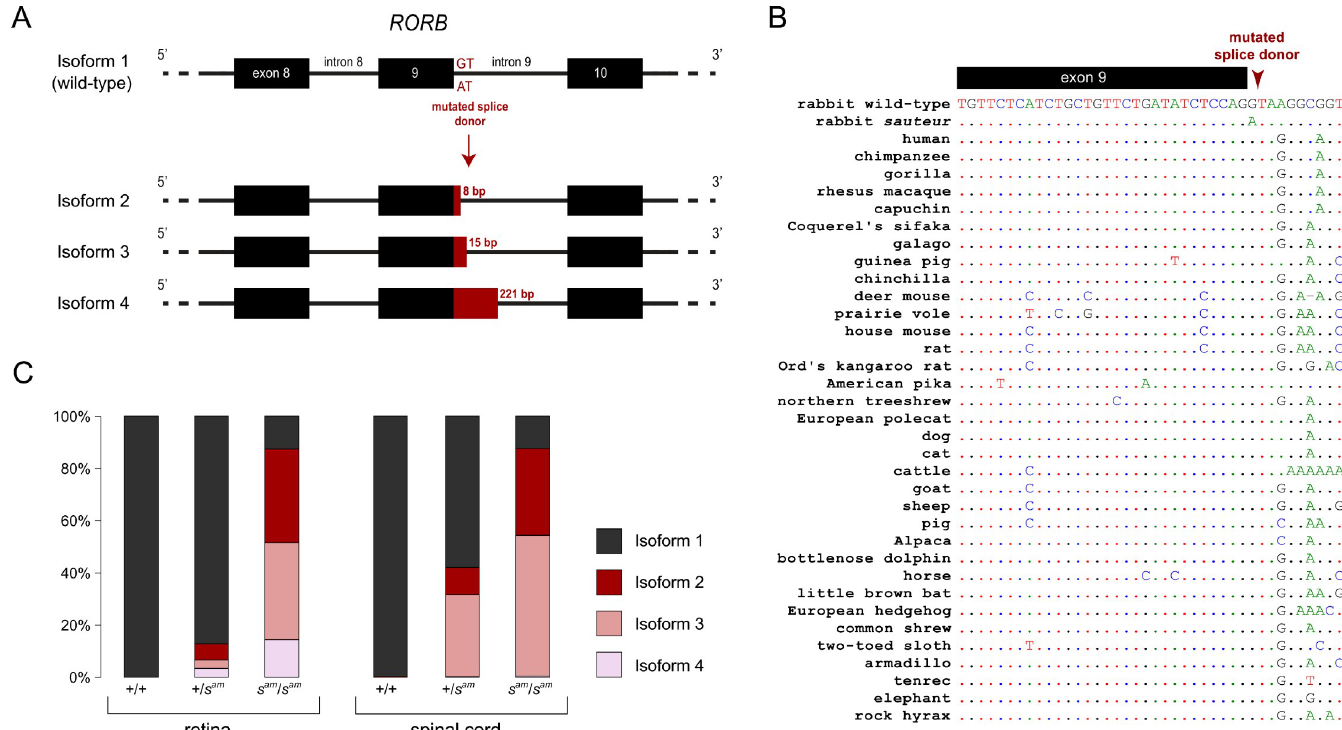
Fig 3. A splice site mutation affects the expression of RORB in sauteur rabbits. (A) The identified mutation in the splice donor site at the end of exon 9 results in three main mutant isoforms, which incorporate varying lengths of intronic sequence into the transcript. (B) Alignment of mammalian sequences at the causal locus, evidencing total conservation of the splice-site donor except for mutant sauteur rabbits. Only a subset of the 70 mammalian species analyzed are presented. (C) Relative abundance of the four main isoforms of RORB mRNA in the retina and spinal cord of rabbits of the three possible genotypes at the sauteur locus. Wild-type (+/+), heterozygous (+/ s am ), and sauteur ( s am / s am ).